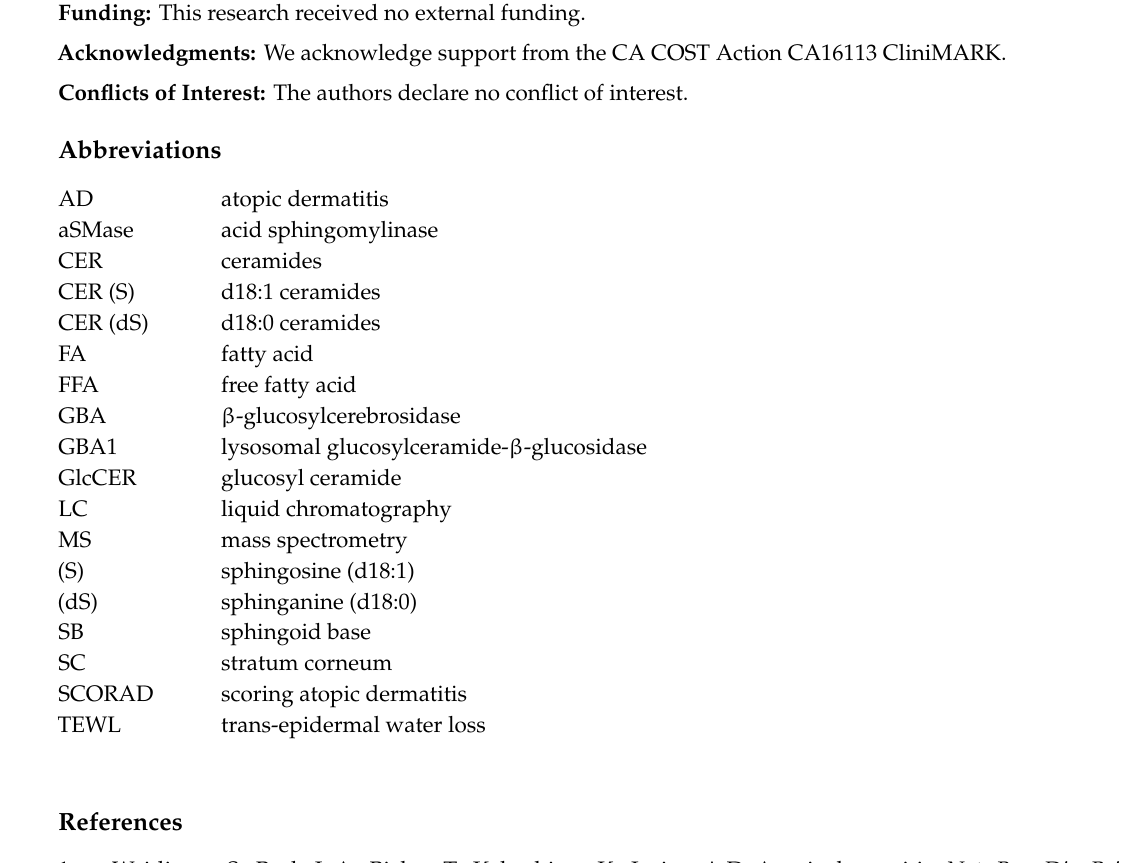
Supplementary Materials: Supplementary Table S1 can be found at http: // www.mdpi.com / 1422-0067 / 21 / 6 / 1958 /